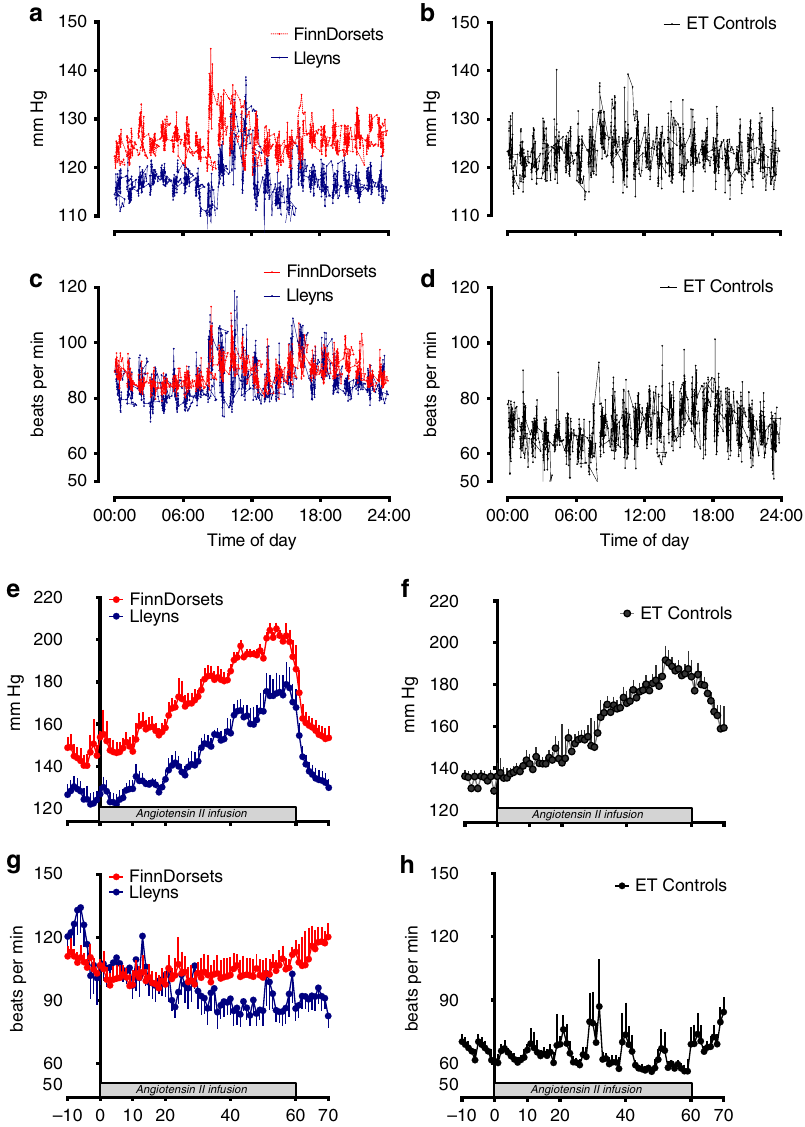
Figure 3 | Ambulatory and Angiotensin-II stimulated systolic blood pressure and heart rate in Finn-Dorset (n ¼ 4) and Lleyn (n ¼ 6) clones, and embryo transfer controls (ET-controls; n ¼ 11). Cardiovascular data were recorded using signals derived from radiotelemetry probes (Telemetry Research, distributed by Millar Ltd, Oxon, UK) implanted into the carotid artery. Data are presented as minute means ± s.e.m. and represent either composite 24h traces of ambulatory systolic blood pressure and heart rate recorded over 3–4 days with sheep group-housed in a floor pen ( a , b , c , d ) or the cardiovascular response to incremental i.v. angiotensin II infusion (0–60ngkg (cid:2) 1 min (cid:2) 1 ) ( e , f , g , h ). Wireless sampling was at 2kHz (that is, beat-to-beat), data downloaded automatically to acquisition software on a laptop (LabChart 7; AD Instruments, Oxon, UK). Shaded box represents period of angiotensin II